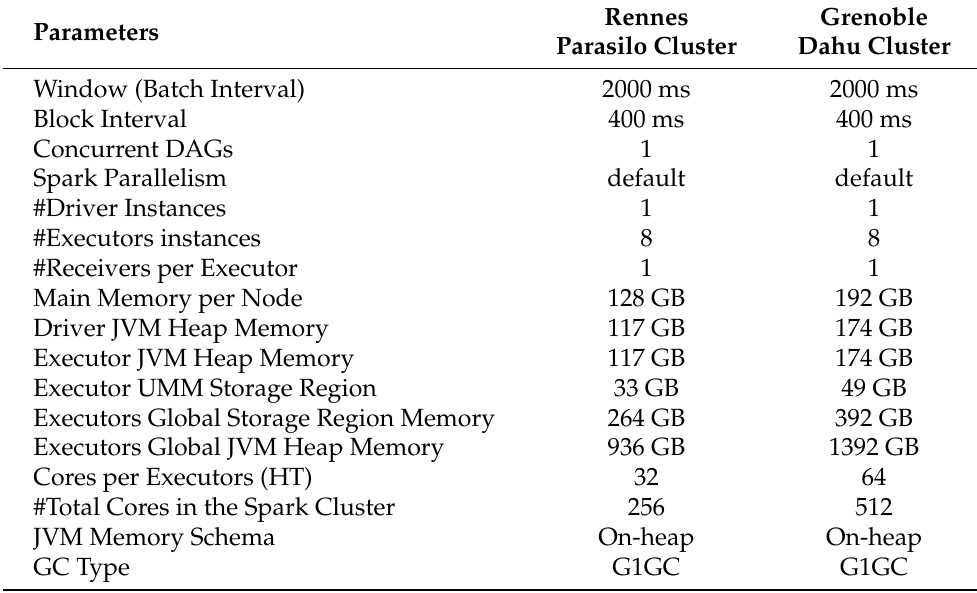
Table 4. Spark Configuration.